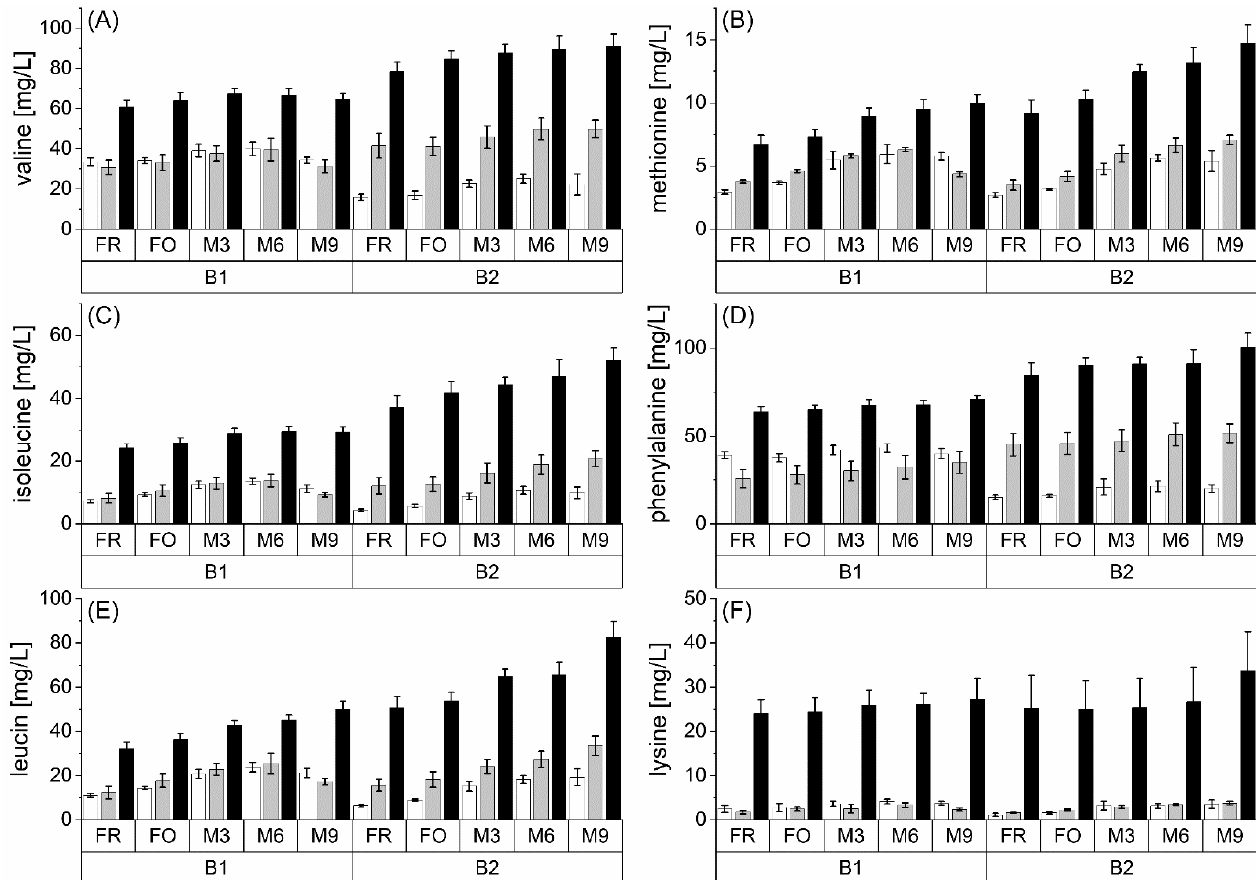
Figure 2. Concentrations of ( A ) valine, ( B ) methionine, ( C ) isoleucine, ( D ) phenylalanine, ( E ) leucine, and ( F ) lysine at fresh (FR), forcibly aged (FO), and naturally aged (M3, M6, and M9) beer at different malt modification levels (P1: white bar; P2: grey bar; P3: black bar) at two barley varieties (B1 and B2); n = 3 .